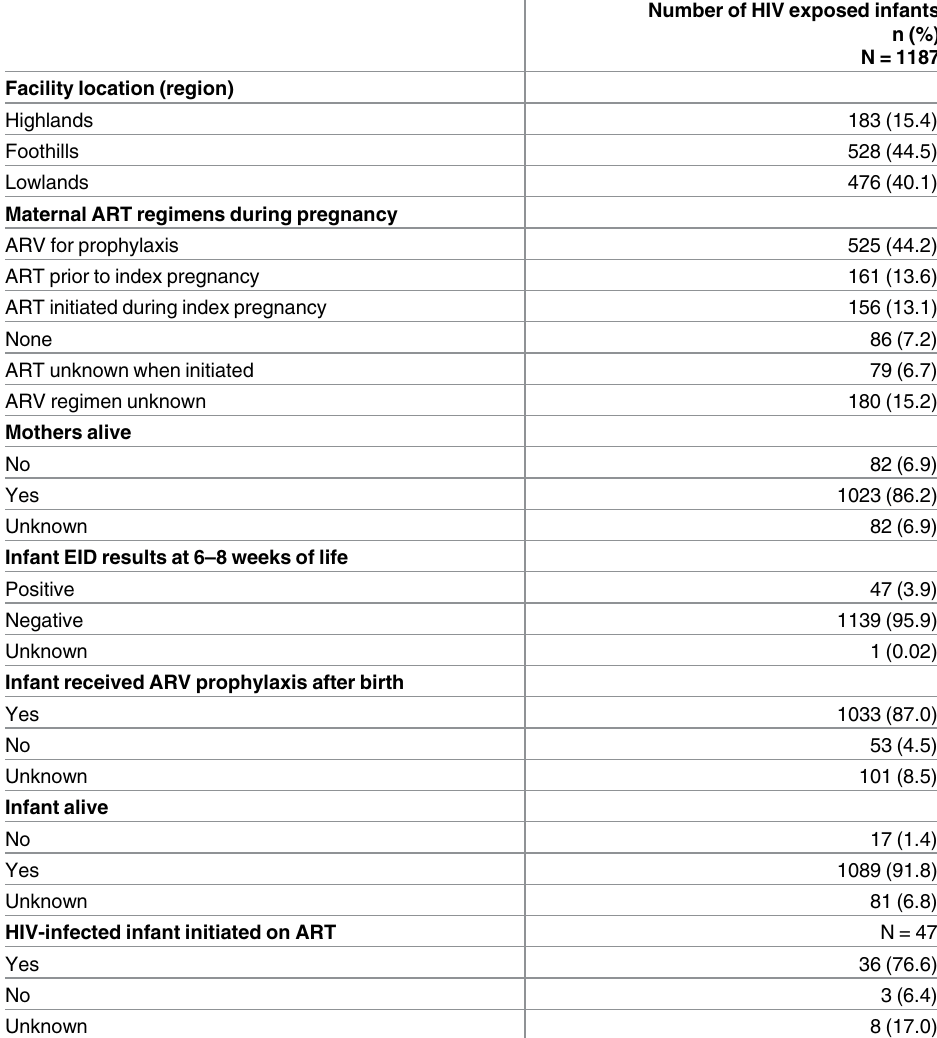
Table 1. Mother and infant